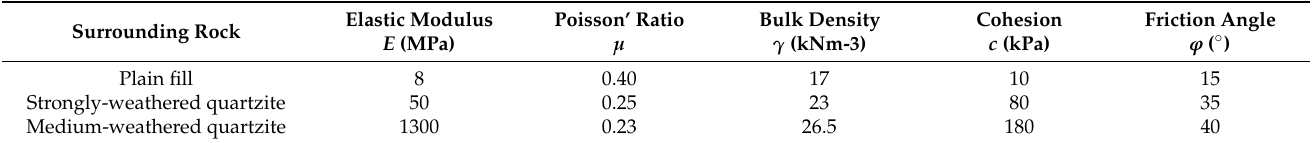
Figure 2. Cross-section view of Shi Kui Subway Station by the arch cover method. Table 1. Physical parameters of surrounding